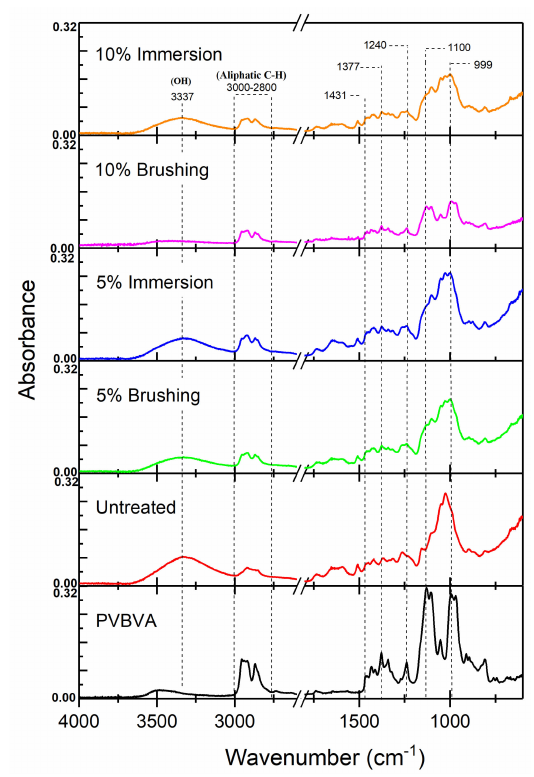
Figure 3. ATR-FTIR spectra of wood samples under study: untreated, 5%-brushing, 10%-brushing, 5%-immersion, and 10%-immersion. Spectra of PVBVA are included for